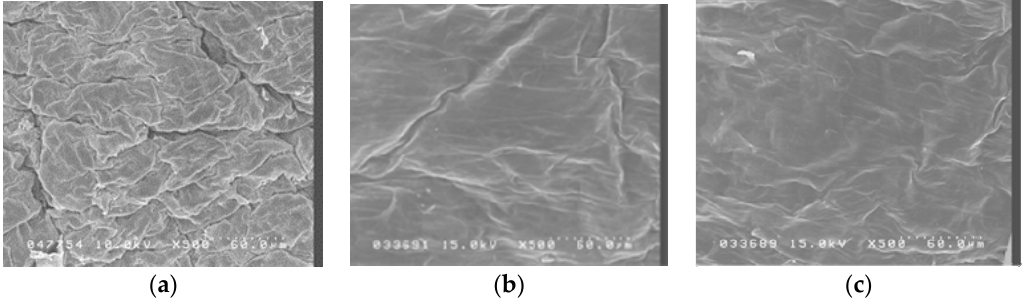
Figure 2. Scanning electron microscopy (SEM) observations (magnification 500×) of porcine skin. ( a ) Without any treatment; ( b ) Fractional CO 2 laser treatment at 12 mm, 5 W; ( c ) Fractional CO 2 laser treatment at 12 mm, 9 W.